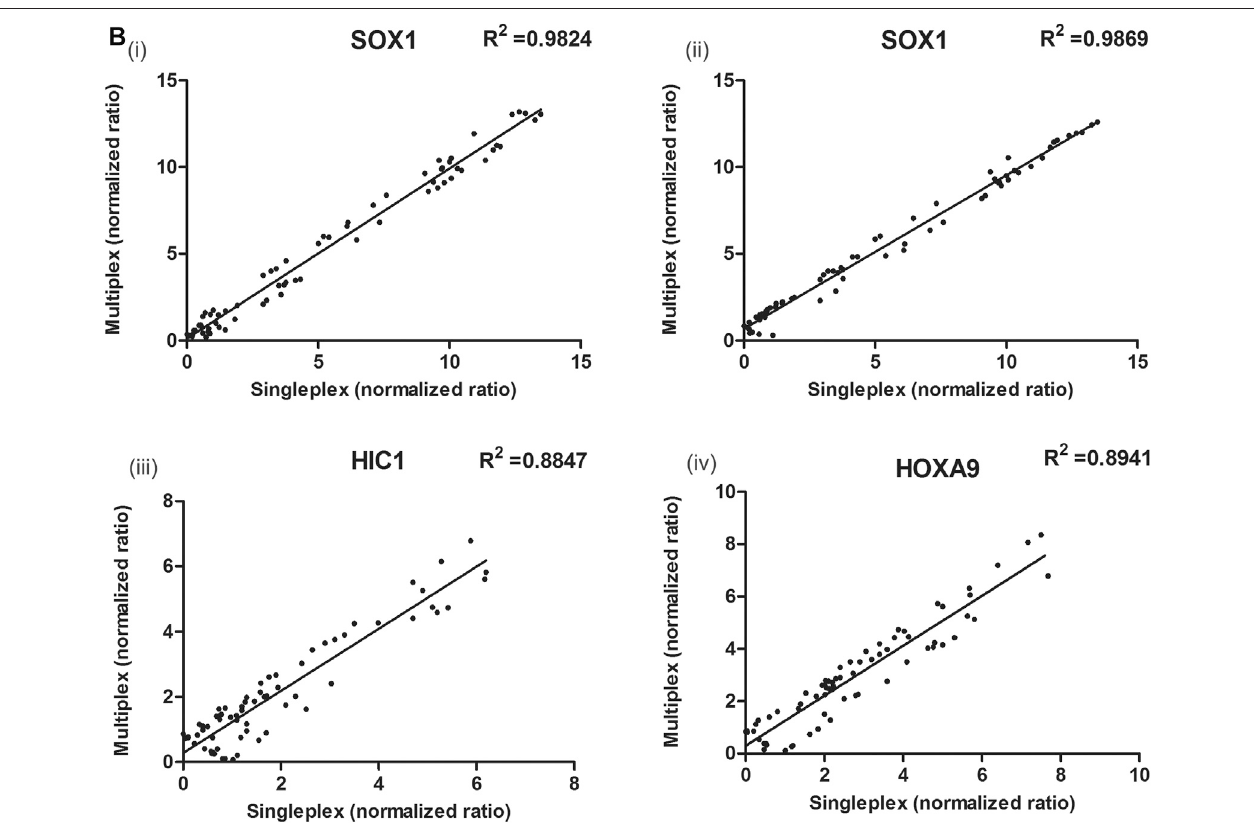
FIGURE 5 | Correlation between the Δ Cq values obtained with singleplex and multiplex assays for (Bi,ii) SOX1 (multiplexed with HIC1 and HOXA9), (iii) HIC1 (multiplexed with SOX1) and (iv) HOXA9 (multiplexed with SOX1) genes, respectively in serum samples. The Δ Cq values between singleplex and multiplex MethyLight assay differ due to differences in set thresholds. The normalized ratios of singleplex and multiplex MethyLight assay for HOXA9 (multiplexed with HIC1) and HIC1 (multiplexed with HOXA9) in serum samples has been previously published (Singh et al.,